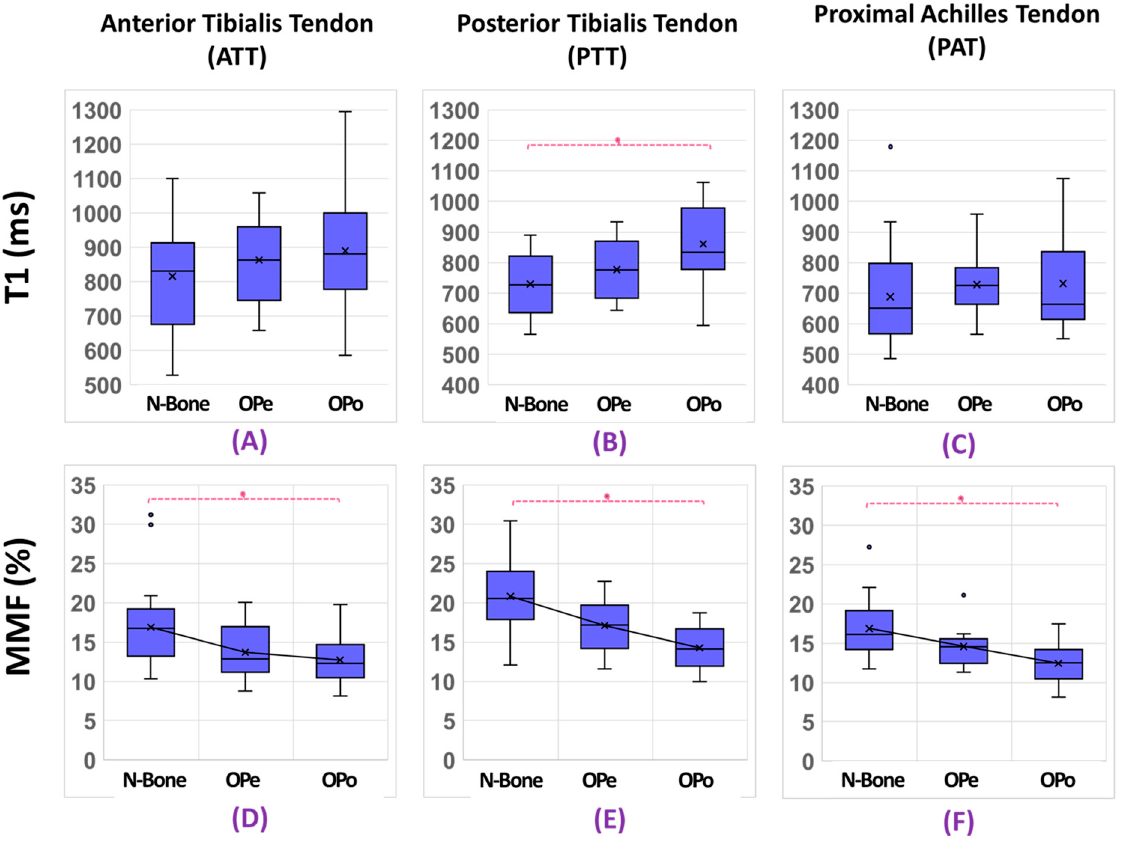
Figure 3. Average UTE-T1 and MMF in ( A , D ) ATT, ( B , E ) PTT, and ( C , F ) PAT for Normal-Bone, OPe, and OPo cohorts. The central mark in each plot indicates the median, while the bottom and top edges of the box indicate the 25th and 75th percentiles, respectively. MMF was significantly lower in OPo patients compared with Normal-Bone cohort for all tendons. T1 was significantly higher in OPo patients compared with the Normal-Bone cohort only for PPT. N-Bone label refers to Normal-Bone